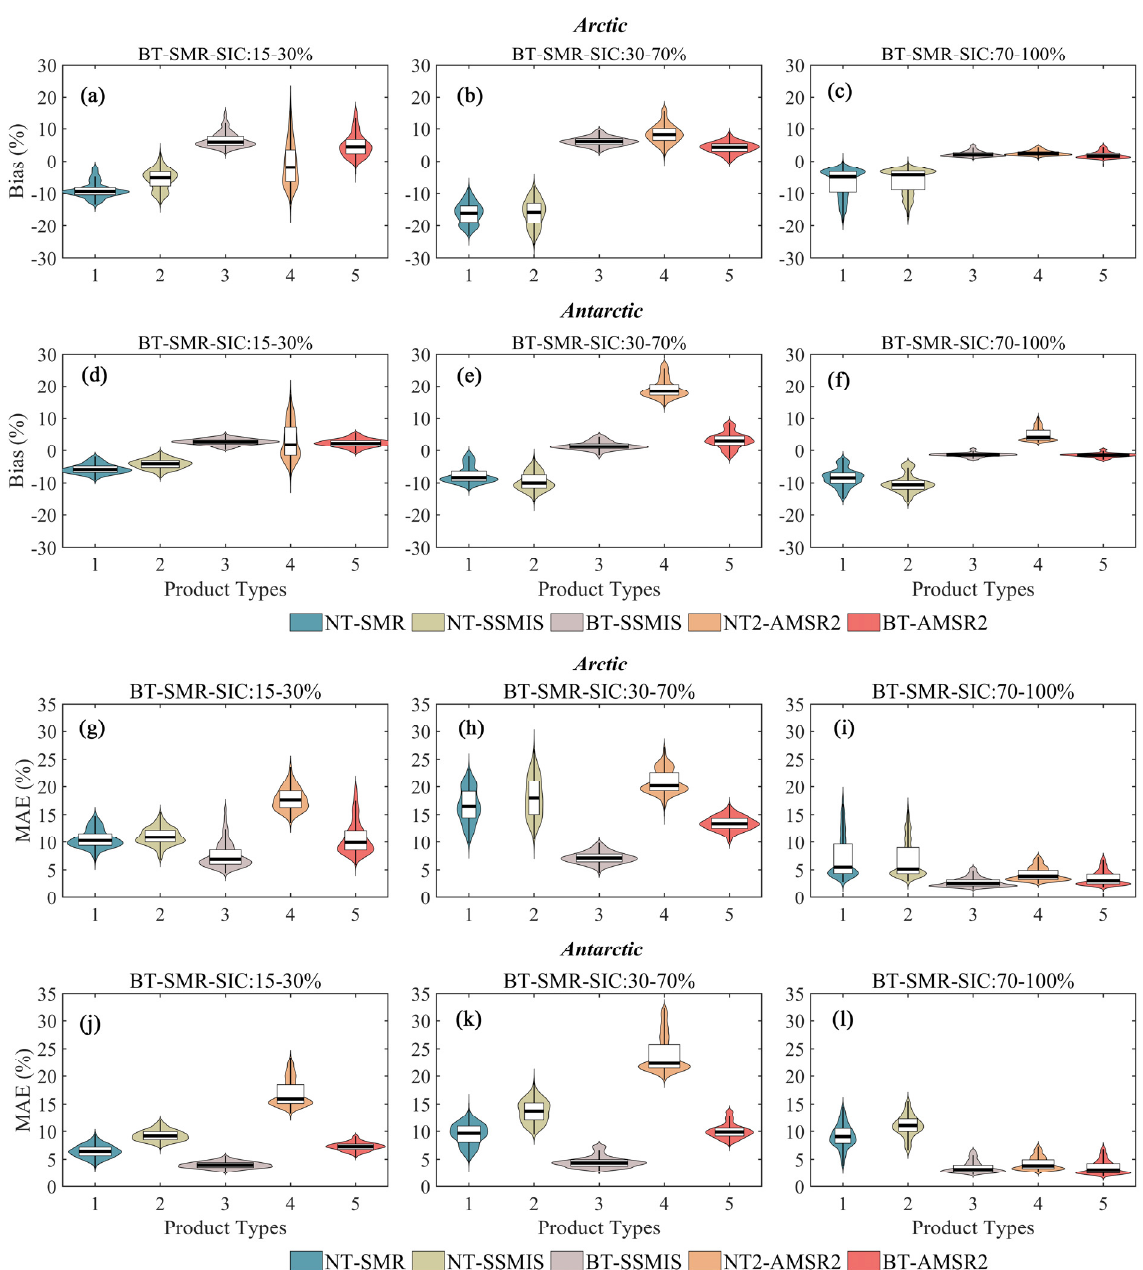
Figure 11. Violin chart of SIC differences between the five different SIC products and BT-SMR SIC with BT-SMR SICs of 15–30%, 30–70%, and 70–100% from January 2019 to December 2021. The x-axis denotes different SIC products; ( a – f ) the y-axis denotes bias; ( g – l ) the y-axis denotes the mean absolute error; the first and third rows of the diagram depict the Arctic, and the second and fourth rows depict the Antarctic.